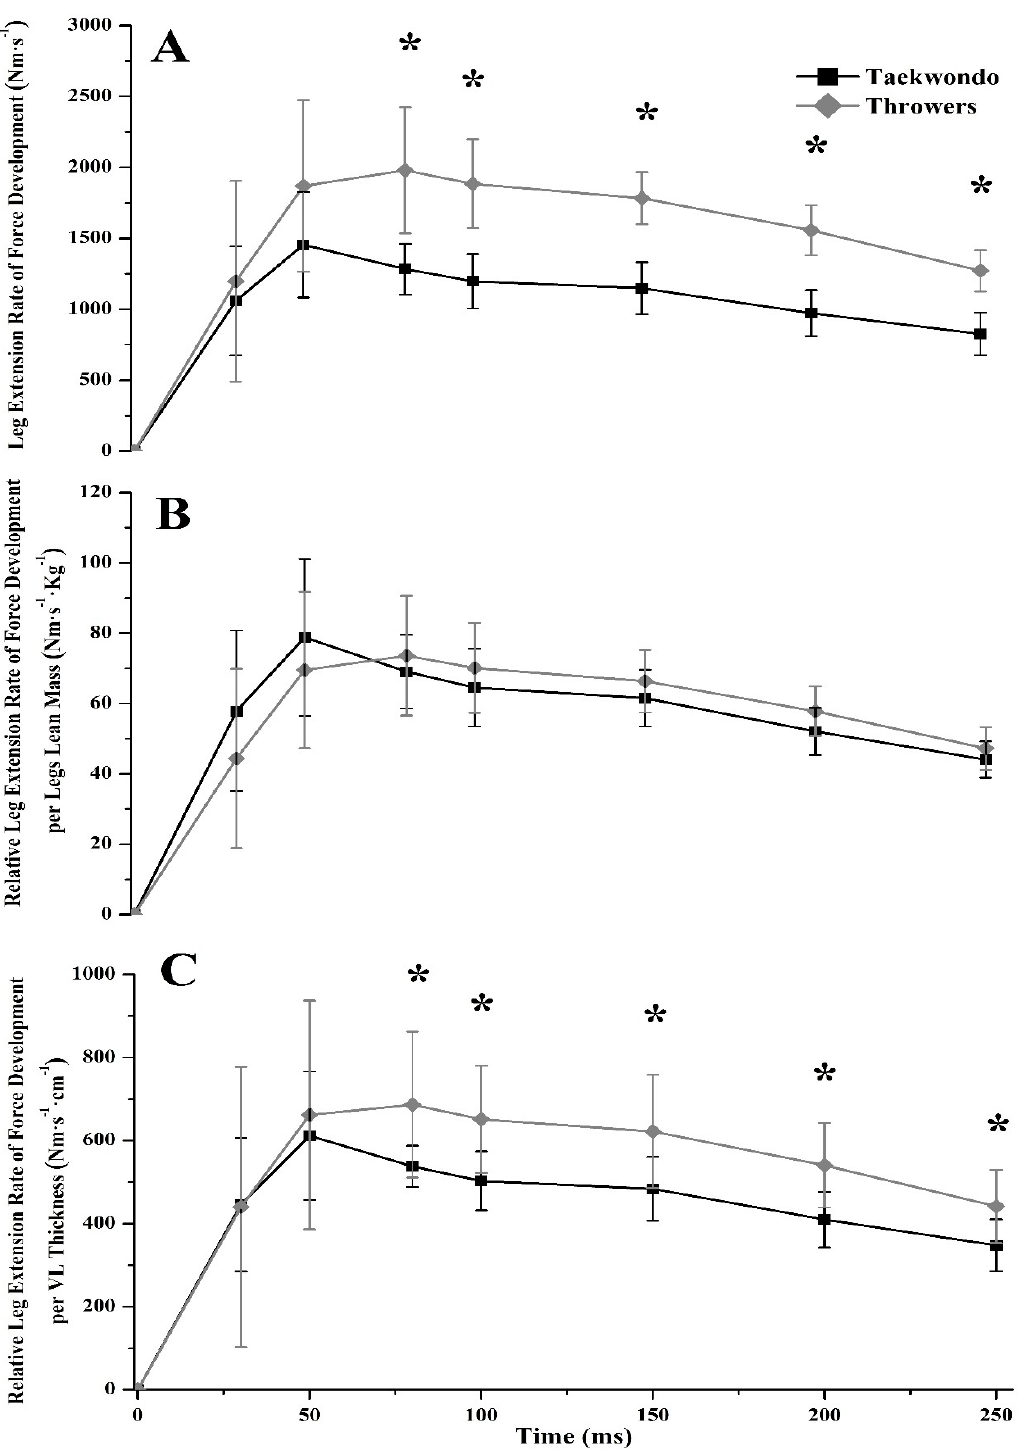
Figure 3. Leg extension rate of force development (RFD) curves calculated for taekwondo athletes (black line) and track and field throwers (grey line). ( A ) Leg extension RFD curve in absolute values. Throwers had significantly higher RFD between 80–250 ms compared to taekwondo athletes (* p < 0.05). ( B ) Leg extension RFD curve relative to legs lean mass. No significant difference was found between taekwondo and throwers. ( C ) Leg extension RFD curve relative to vastus lateralis muscle thickness. Throwers had significantly higher RFD between 80–250 ms as compared to taekwondo athletes (* p < 0.05).